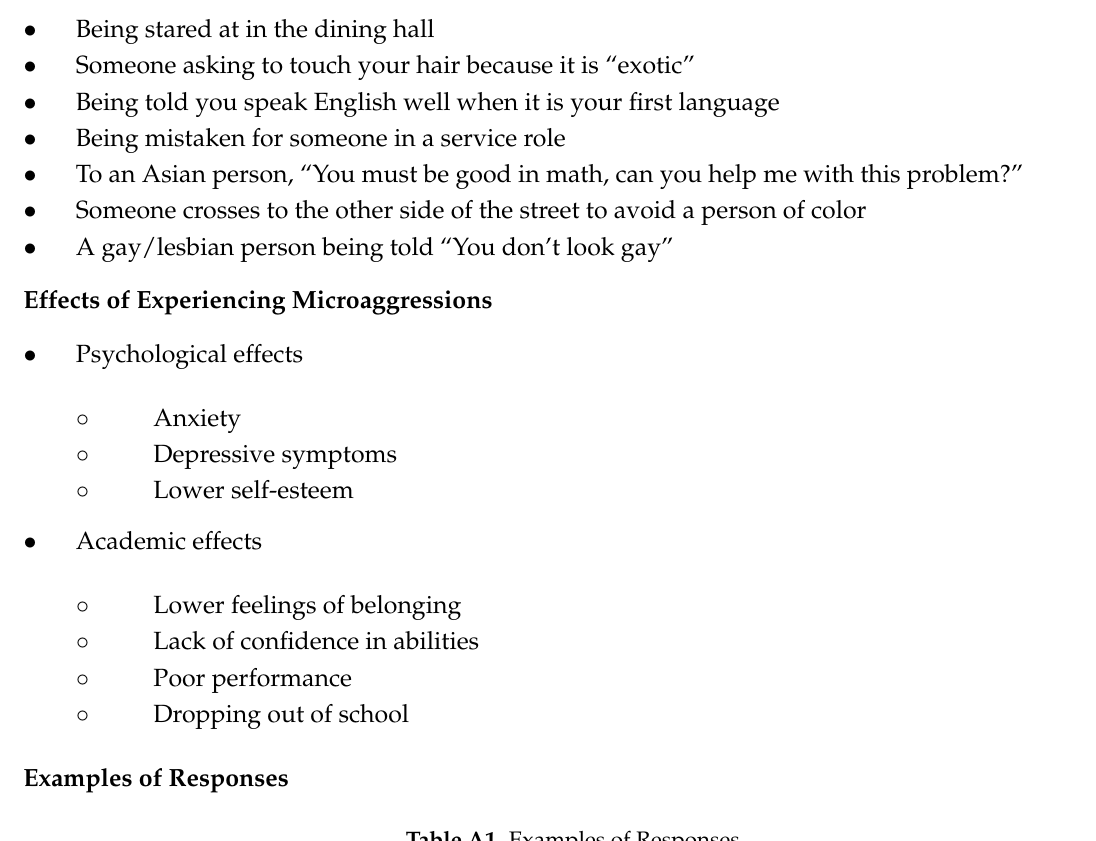
Table A1. Examples of